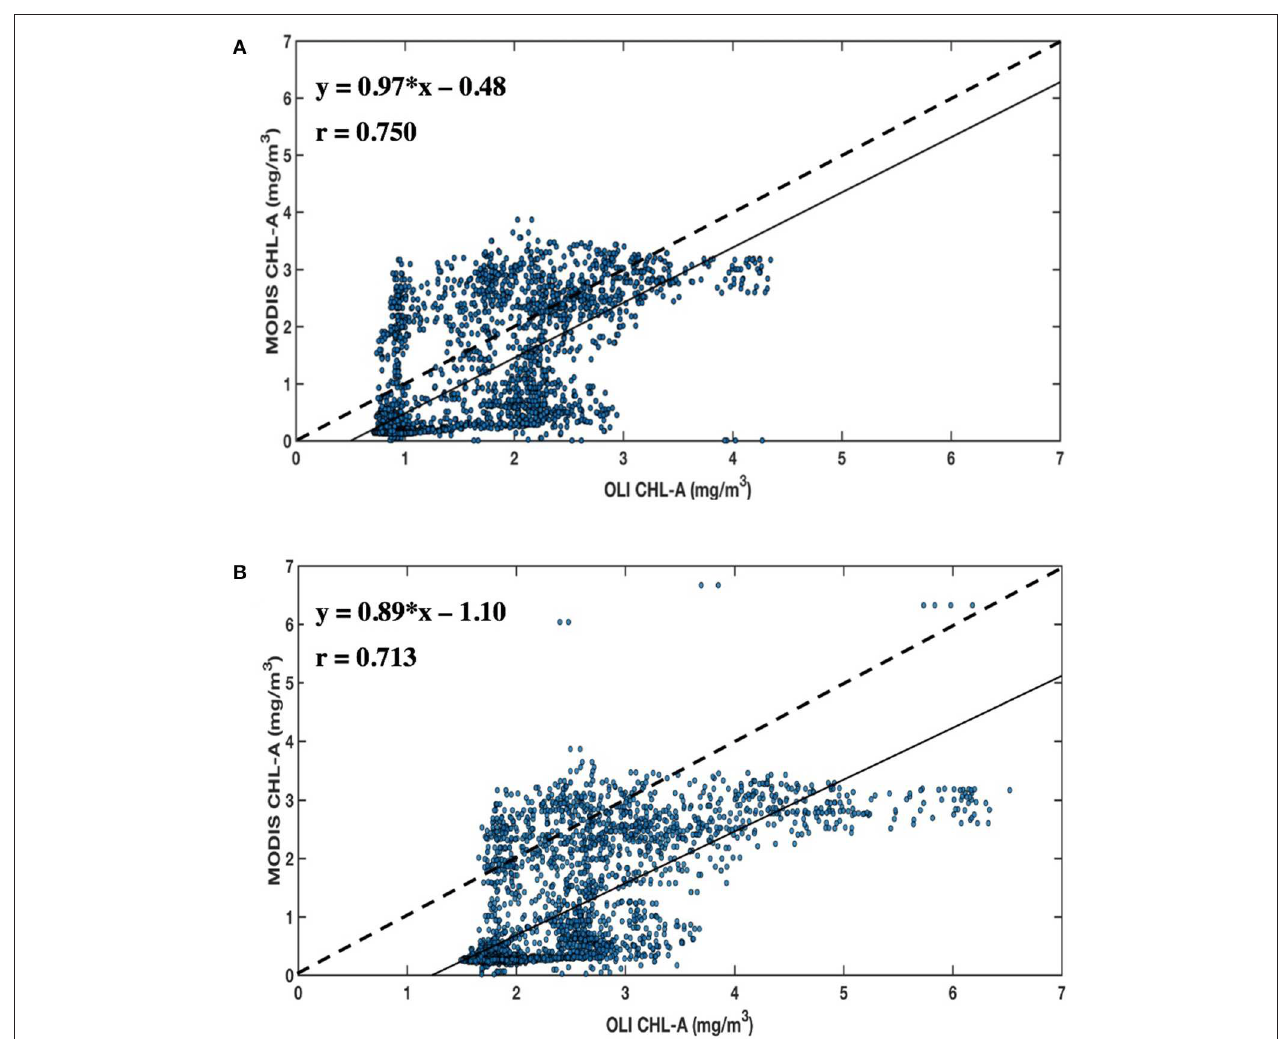
FIGURE 2 | Scatter plots of the Chl- a from MODIS-A vs. Landsat-8 OLI for (A) OC-2 algorithm and (B) OC-3 algorithm,